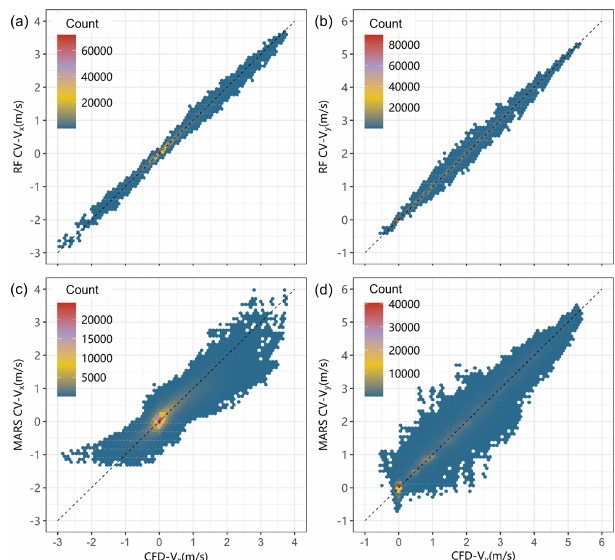
Figure 4. Cross-validations of machine learning models for V x (a, c) and V y (b, d) : (a–b) RF model; (c–d) MARS model.